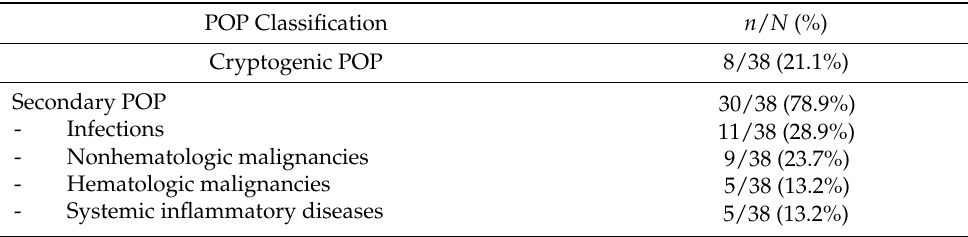
Table 1. Final clinical diagnoses of N = 38 study patients with peripheral organizing pneumonia (POP).